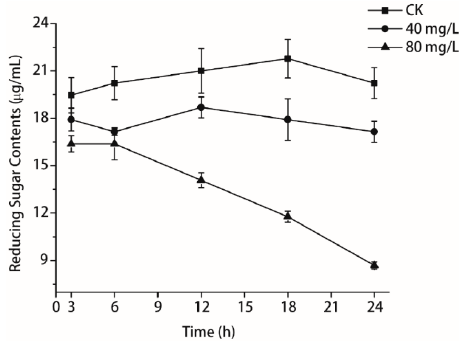
Figure 7. Effects of isoliquiritin on the reducing sugar contents of P. litchii Chen. Values were mean ( n = 3) ± S.E.